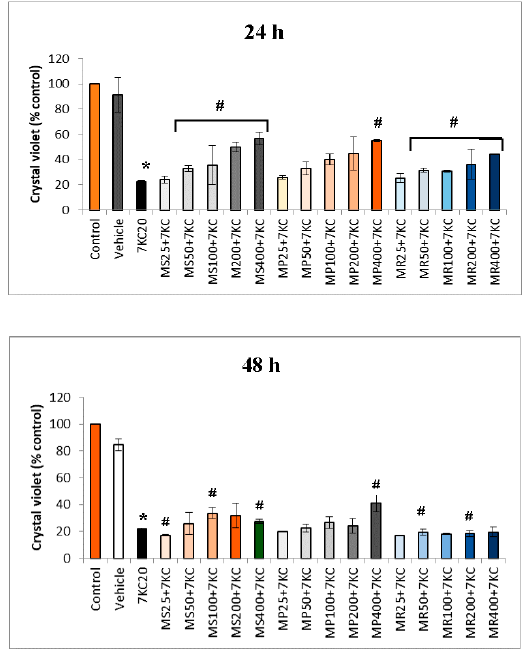
Figure 1. Attenuation with ethanolic mint extracts of 7-ketocholesterol (7KC)-induced cell growth inhibition. The effects of Mentha extracts were evaluated on 7KC (20 µ g/mL (50 µ M); 24 h and 48 h)-treated RAW 264.7 cells with the crystal violet test, which allows the quantification of adherent cells. After 24 h of culture, mint extracts and 7KC were simultaneously added to the culture